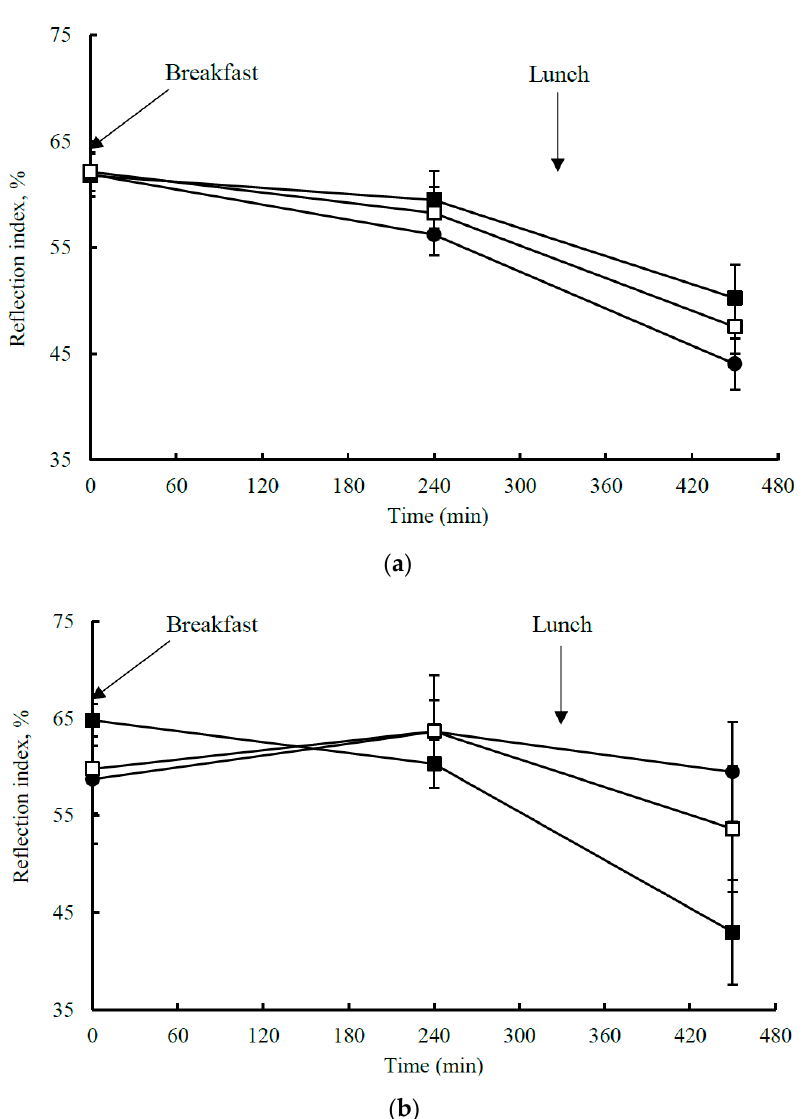
Figure 1. Mean ± SEM for the postprandial digital volume pulse reflection index (DVP-RI) response in ( a ) the E3/E3 group ( n = 22) and ( b ) E4 carriers ( n = 5) response following sequential meals (breakfast: 0 min and lunch: 330 min) enriched in saturated fatty acids (SFA; (cid:4) ), monounsaturated fatty acids (MUFA; (cid:3) ) and n -6 polyunsaturated fatty acids (PUFA; (cid:8) ). Two-way repeated measures